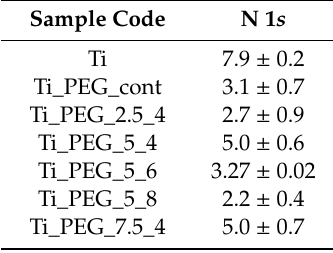
Table 3. Fibronectin adsorption in the samples indicated as the atomic % of the N 1 s by XPS.